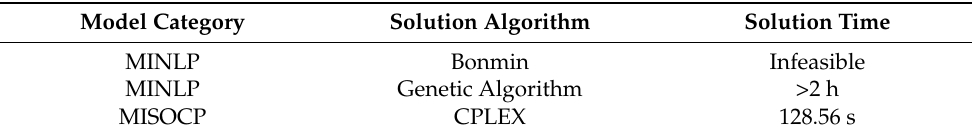
Table 4. Comparison of solving efficiency of different